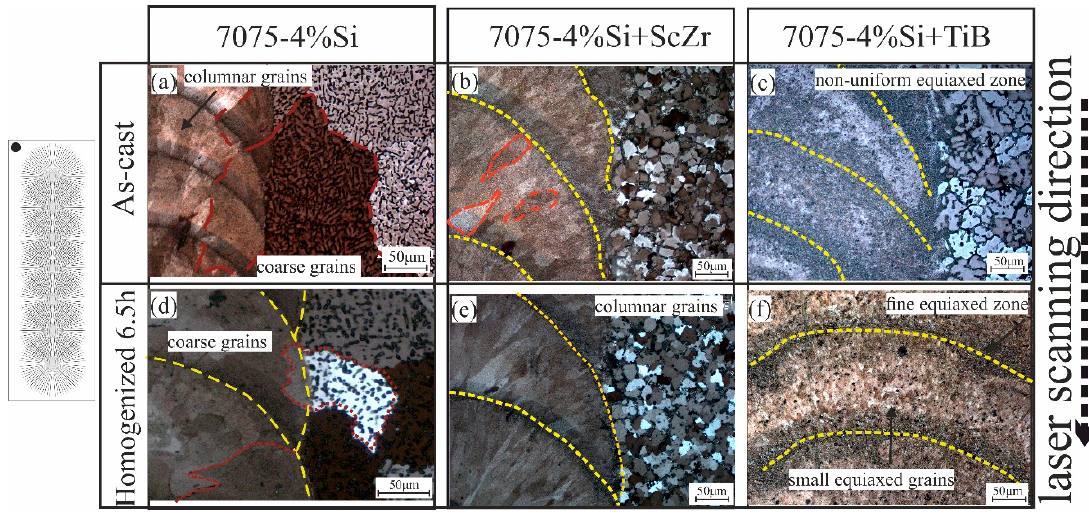
Figure 6. Optical micrographs (top view) of the LMZ for the as-casted and the homogenized samples; ( a , d ) 7075-4%Si, ( b , e ) 7075-4%Si + ScZr, and ( c , f ) 7075-4%Si + TiB.